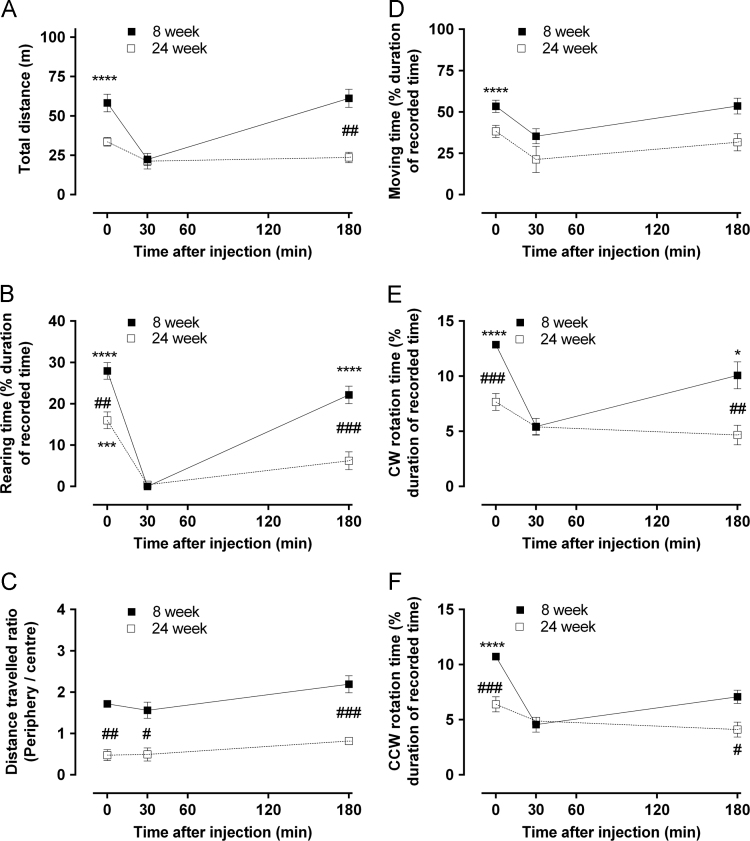
Detailed analysis of high dose morphine-induced behavioral changes. Six distinct animal behavior (A. Moving time, B. distance, C. rearing time, D. clockwise (CW) rotation time, E. Counter-clockwise (CCW) rotation time, and F. the ratio of distance travelled in periphery vs center were recorded after a single-dose of morphine (10 mg/kg, s.c.) in 8 and 24 week old rats and were analyzed using ActiMot software (TSE Systems). Measurements were taken prior to drug administration (basal), 30 and 180 min post-administration, as described in Section 2. Differences between the 30 min time point and the basal or 180 min time points were significantly different (*p<0.05, ***p<0.001 and ****p<0.0001, using repeated measure one-way ANOVA with Sidak's multiple comparison post hoc test). Likewise, significant differences against 8 week old animals were observed for some time points (##p<0.01 and ###p<0.001, using non-repeated measure one-way ANOVA with Sidak's multiple comparison post hoc test). All data are presented as mean±SEM, n=5 per group.